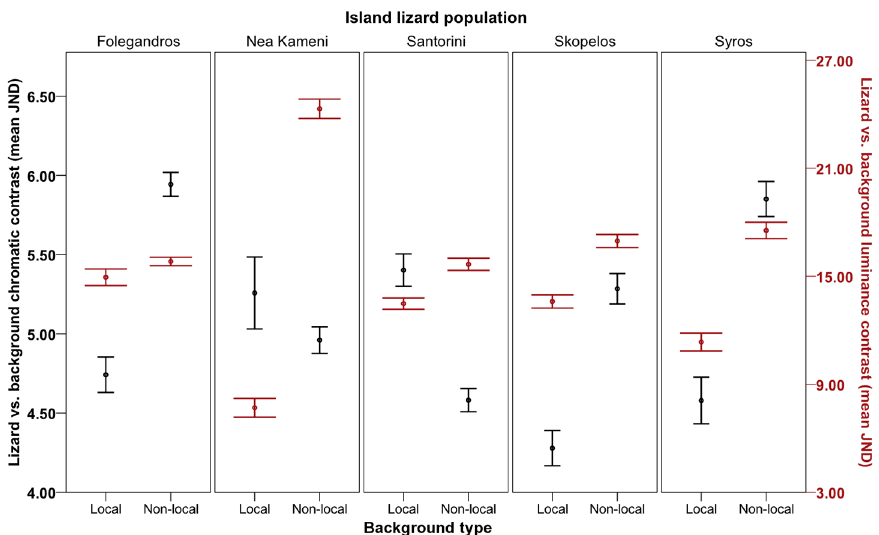
Fig 4. Local vs. non-local camouflage of Aegean wall lizards ( Podarcis erhardii ). Degree of dorsal camouflage is shown against local island backgrounds and against different (non-local) island backgrounds overall (Folegandros, Nea Kameni, Santorini, Skopelos and Syros). Degree of camouflage is shown in terms of chromatic contrast (left axis; black data points) and luminance contrast (right axis; red data points) of lizards ’ dorsal regions against the background (mean JND). JND values increasing > 3.00 depict lizards that are progressively distinguishable from the background by avian predators. Error bars represent +/- 1 S.E.